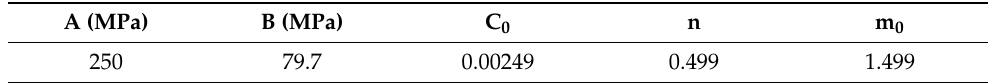
Table 1. Johnson-Cook constants of A6061